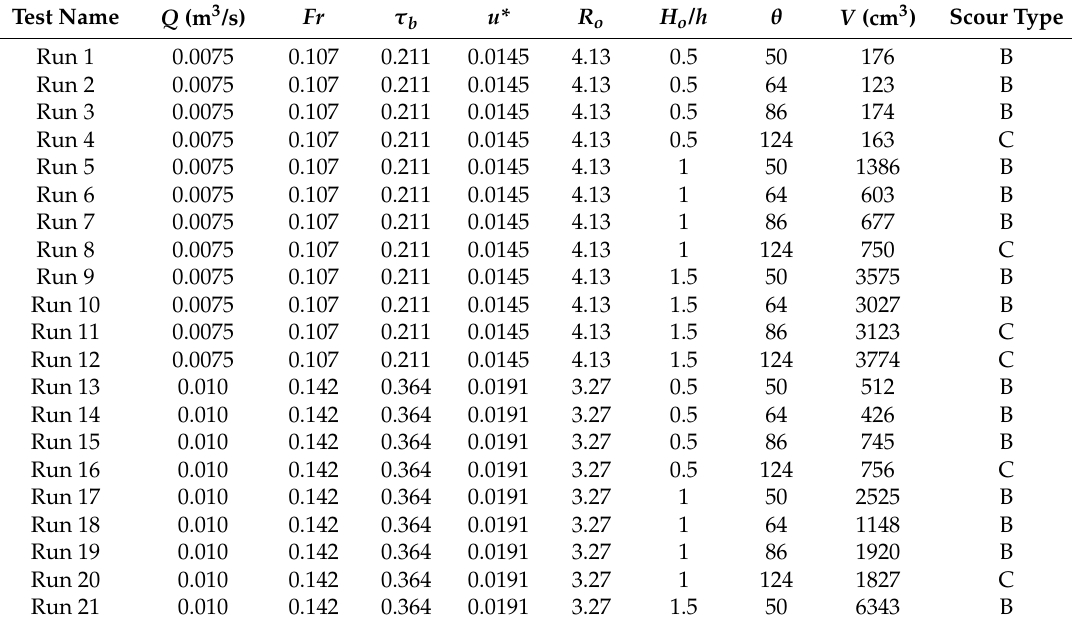
Table 2. List of the experiments carried out in the present study.